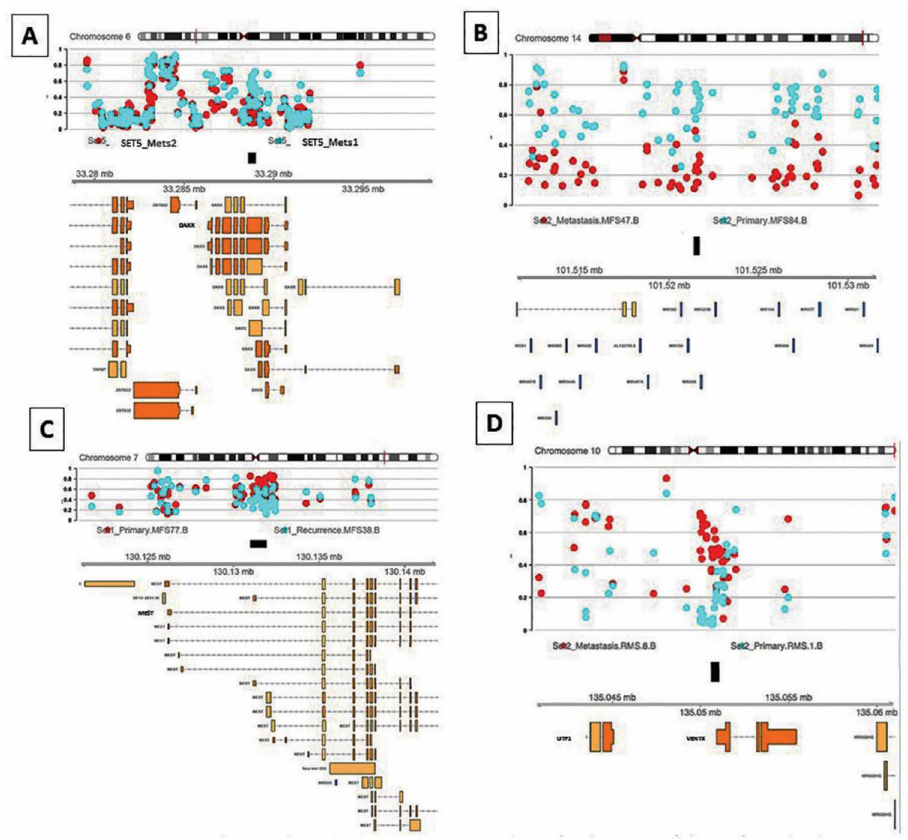
Figure 3. B-values and genomic annotation for some of the top differentially methylated regions (DMRs) of the genome detected in Leiomyosarcoma (LMS), myxofibrosarcoma (MFS) and Pleomorphic Rhabddomyosarcoma (Ple RMS). In LMS Set 5 ( A ) the top result was in the DAXX gene on chromosome (chr) 6. In MFS top DMRs were located on chr. 14 within the human microRNA cluster, C14MC (Set2: B ) and chr. 7 containing the Mesoderm specific transferase ( MEST ) gene (Set1: C ). In Ple-RMS ( D ), the top DMR was located to chr.10 around the UTF1, VENTX and MIR202HG